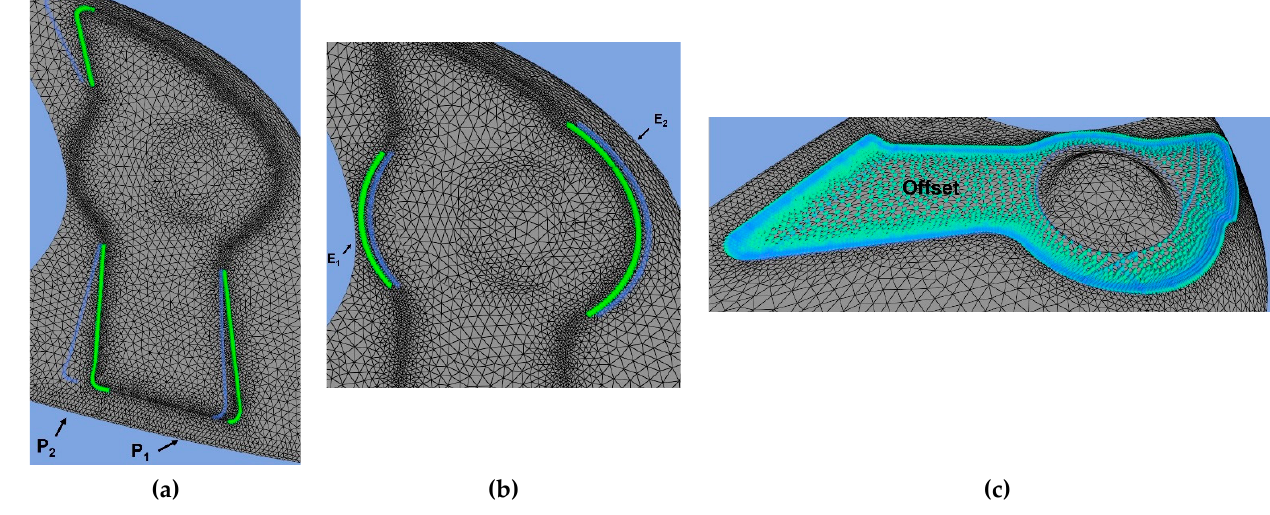
Figure 10. Parameterization of the mirror geometry acting on the straight borders ( a ), on the curved sides ( b ) and on the pocket ( c ).